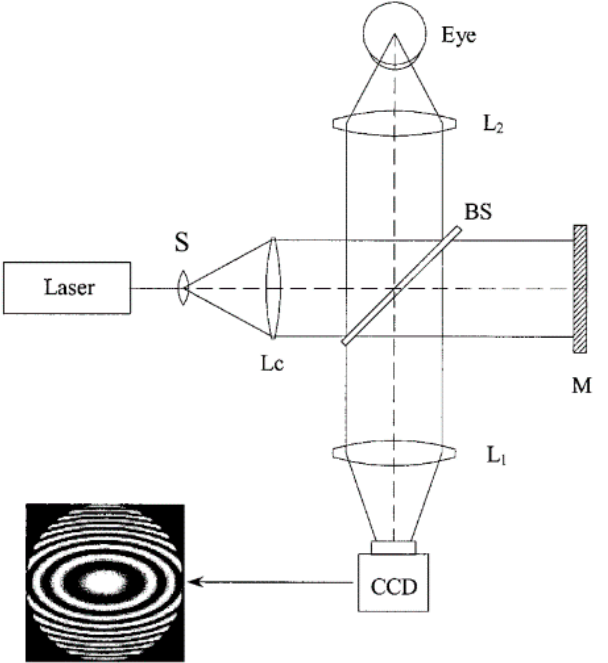
Figure 10. Twyman-Green interferometer for testing the corneal surface [43].